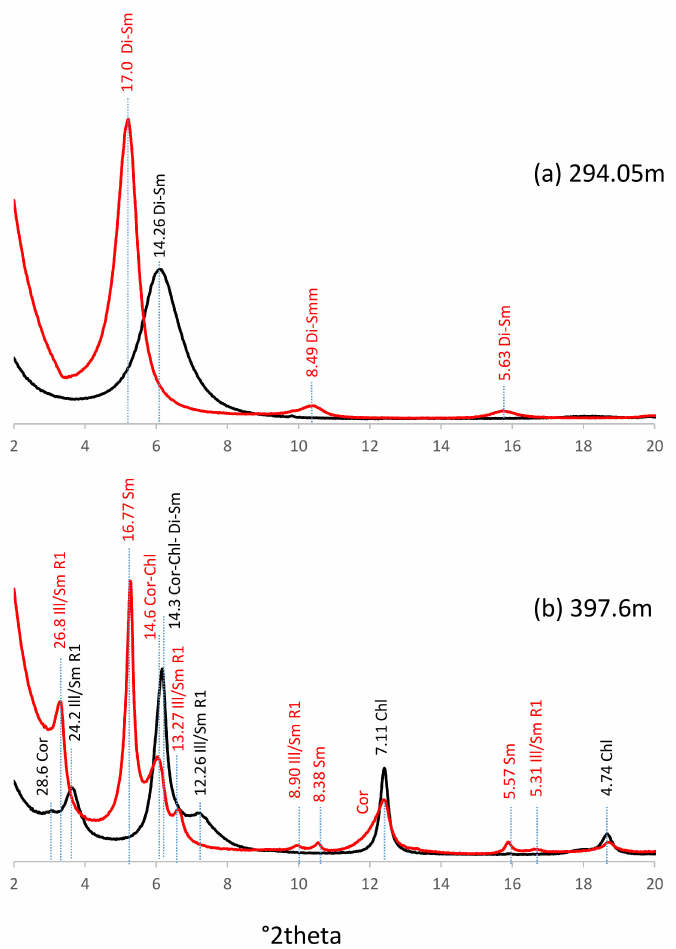
Figure 6. X-ray diffractograms of oriented preparations: infra 2 µ m clay fraction. In black: air dried; in red: ethylene glycol-solvated preparation. Di-Sm: dioctahedral smectite, Ill/Sm R1: regular illite/smectite, Cor: corrensite, and Chl: chlorite. The dioctahedral nature of smectite was confirmed by chemical microanalyses using